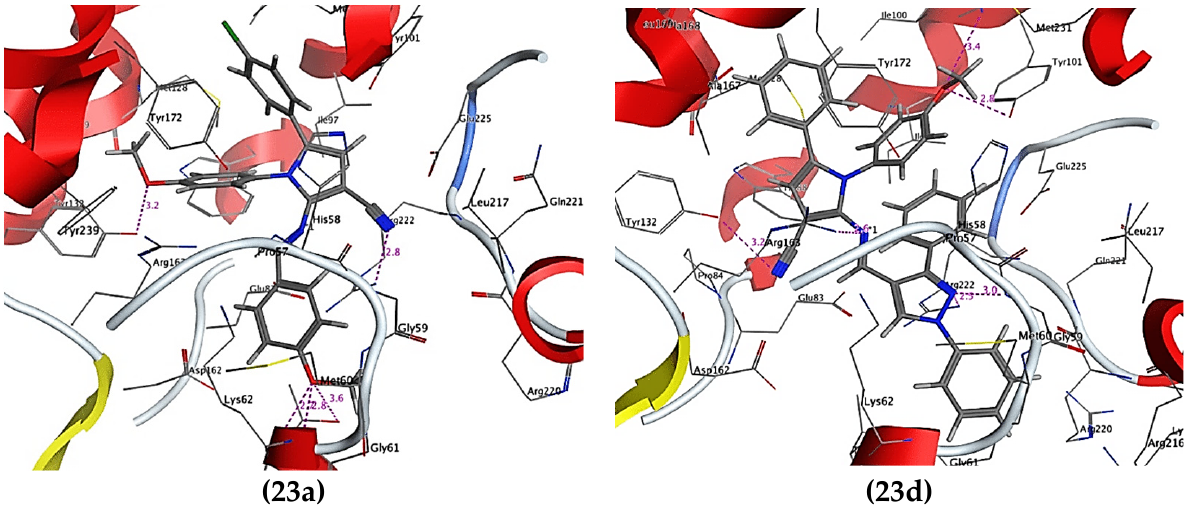
Figure 4. Docking study of 23a and 23d in the binding site of HSV-1 thymidine kinase [33].